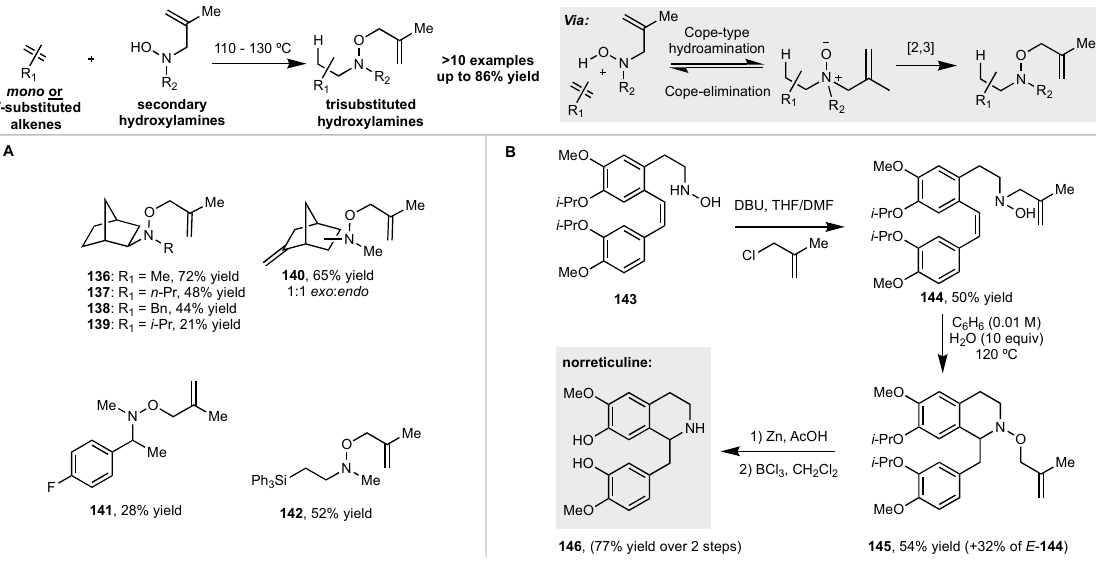
Scheme 14. Beauchemin(cid:31)s tandem Cope-type hydroamination/[2,3]-rearrangement for the synthesis of trisubstituted hydroxylamines. ( A ) Selected examples of the transformation. ( B ) Application of the method to the total synthesis of the alkaloid norreticuline